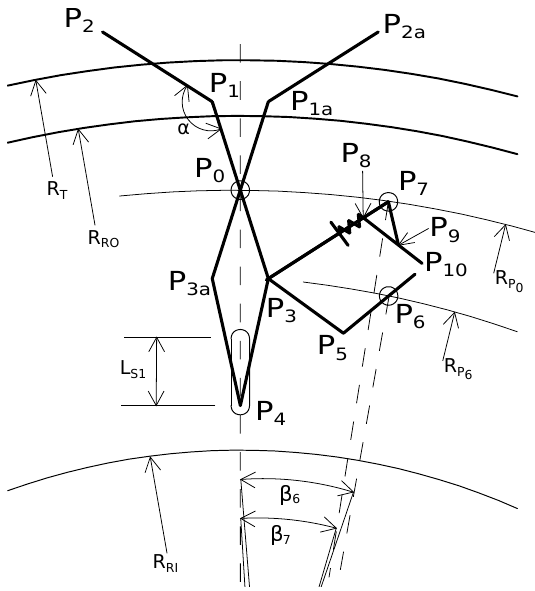
Figure 4. Schematic view of the anti-slip